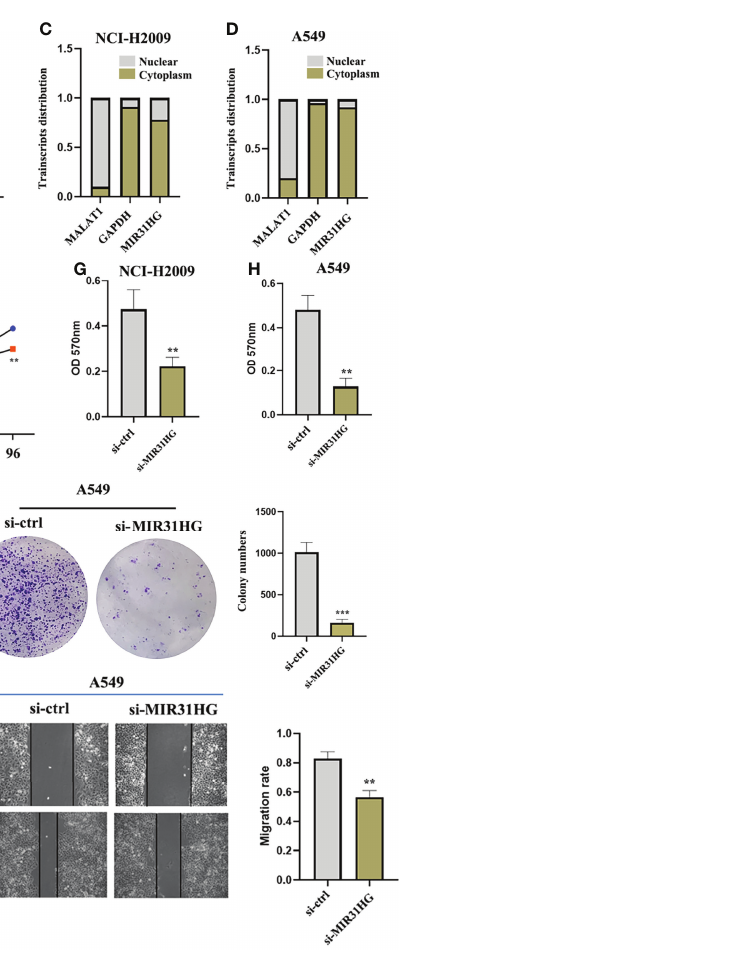
FIGURE 8 The effect of lncRNA MIR31HG on lung adenocarcinoma LUAD cell viability, migration, and invasion. (A) The ef fi ciency of MIR31HG knockdown (si-MIR31HG-1 and si-MIR31HG-2) was assessed by qRT-PCR. (B) The subcellular localization of MIR31HG was predicted by “ LncLocator ” . (C, D) The relative lncRNA MIR31HG expression level both in the cytoplasm and the nucleus of the NCI-H2009 and A549 cell lines were simultaneously measured by qRT-PCR. (E, F) The proliferation of NCI-H2009 and A549 cells was detected by CCK-8 assays. (G, H) The invasion of NCI-H2009 and A549 cells was investigated by transwell assays. (I, J) The clone capacity of NCI-H2009 and A549 cells was identi fi ed by colony formation assay. (K, L) The migration of NCI-H2009 and A549 cells was determined by wound healing assays. * p < 0.05; ** p < 0.01; *** p <